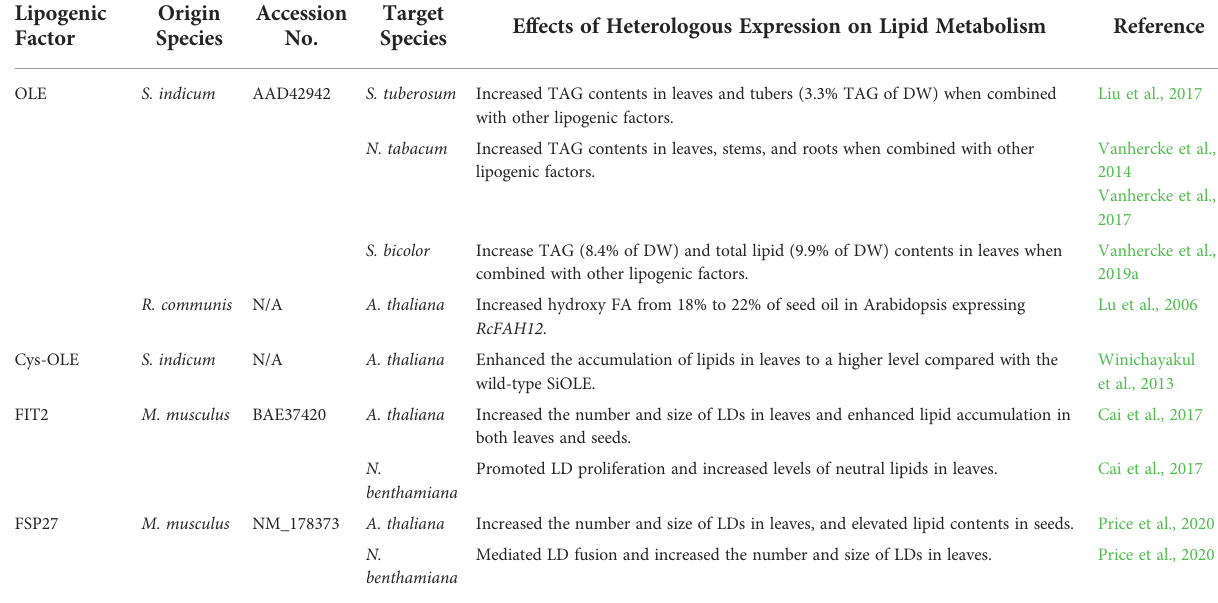
TABLE 3 List of specialized lipogenic factors involved in LD biogenesis used for lipid engineering in